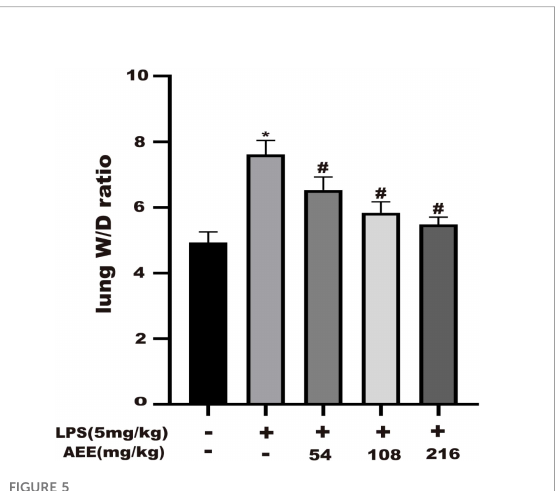
Figure 5, compared with the control group, the W/D ratio of the LPS group was signi fi cantly increased, which indicated that LPS treatment signi fi cantly increased the W/D ratio. However, the W/D ratio of lung tissue was signi fi cantly decreased in a dose- dependent manner after AEE treatment compared with the LPS group.